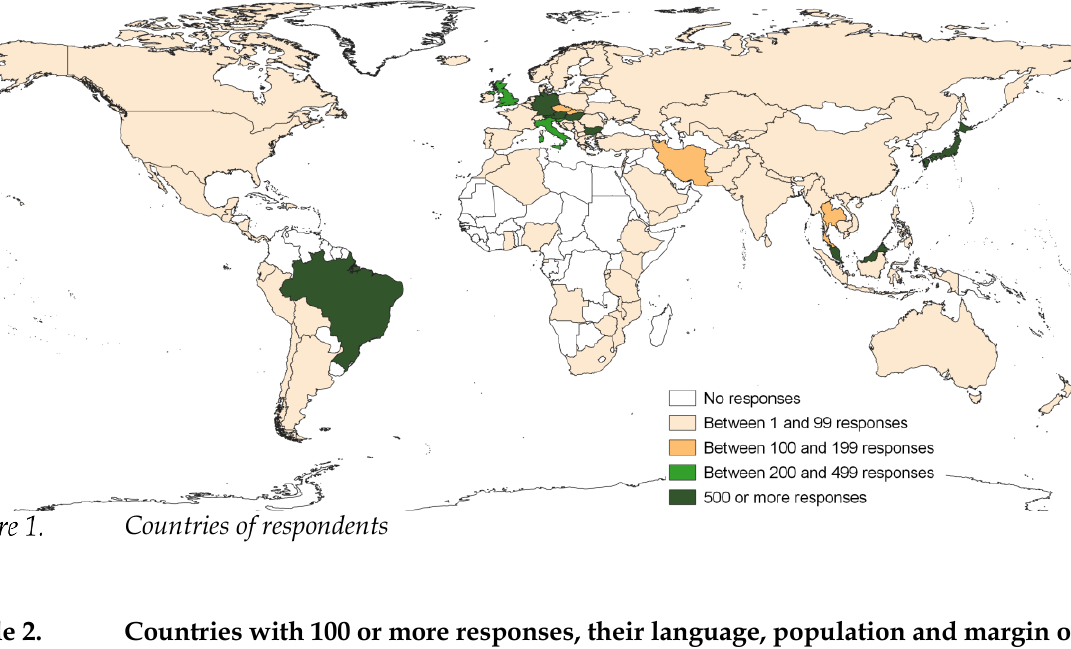
Table 2. Countries with 100 or more responses, their language, population and margin